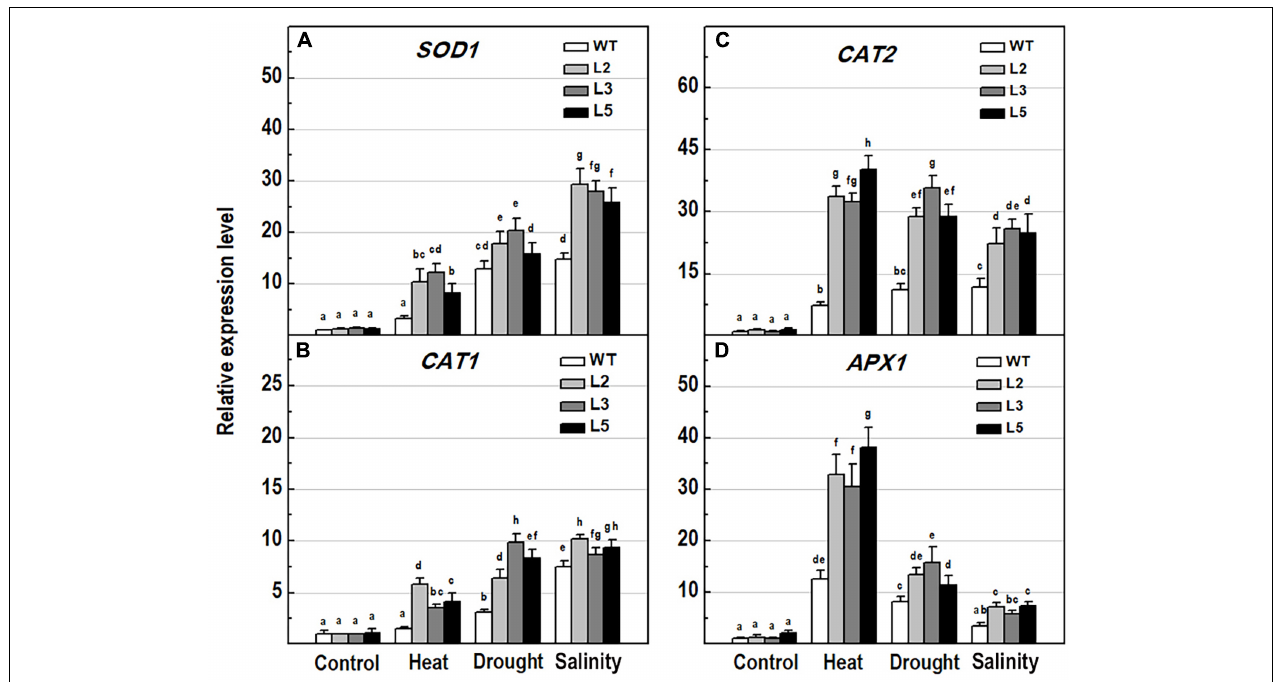
FIGURE 9 | Analysis of the expression levels of major antioxidant genes in 10-day-old wild-type seedlings and transgenic lines overexpressing NMig1 (L2, L3, and L5) after exposure to heat shock, drought and high salinity: (A) SOD1 , (B) CAT1 , (C) CAT2 , and ( D ) APX1 . Expression levels were normalized to those of EF1a and CDKA1;1 , as described in section “Materials and Methods.” Data represents the mean values ± SE from at least three biological replicates. Different lowercase letters indicate statistically significant difference ( p ≤